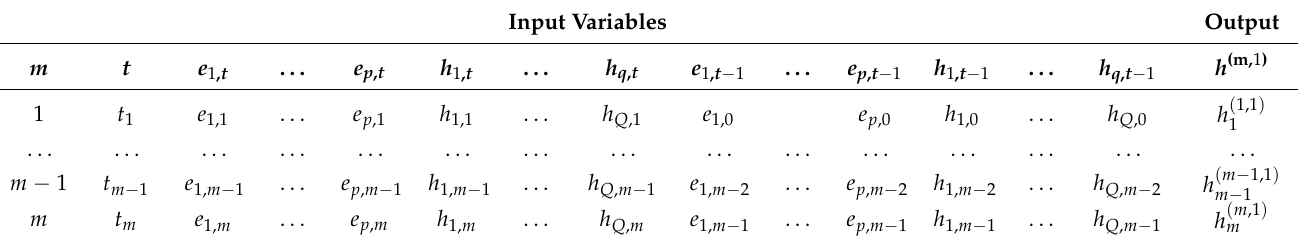
Table 4. Truth table of the MVL ledger function h ( m ,1 ) = F ldg ( m , t , e m , e m − 1 , h m , h m − 1 ) , whose input variables are the newcomer entry e m = ( e 1, m ,..., e n , m ) , previous entry is e m − 1 = ( e 1, m − 1 ,..., e n , m − 1 ) , and their corresponding sets of hash values h m = time t m and t m − 1